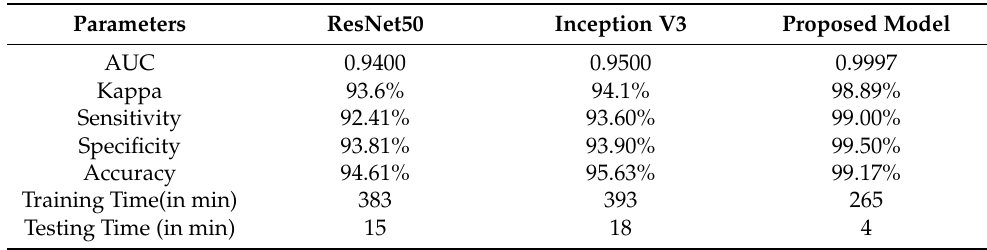
Table 2. Performance of VGG-19 based transfer-learning model and its comparison with pre-existing models.